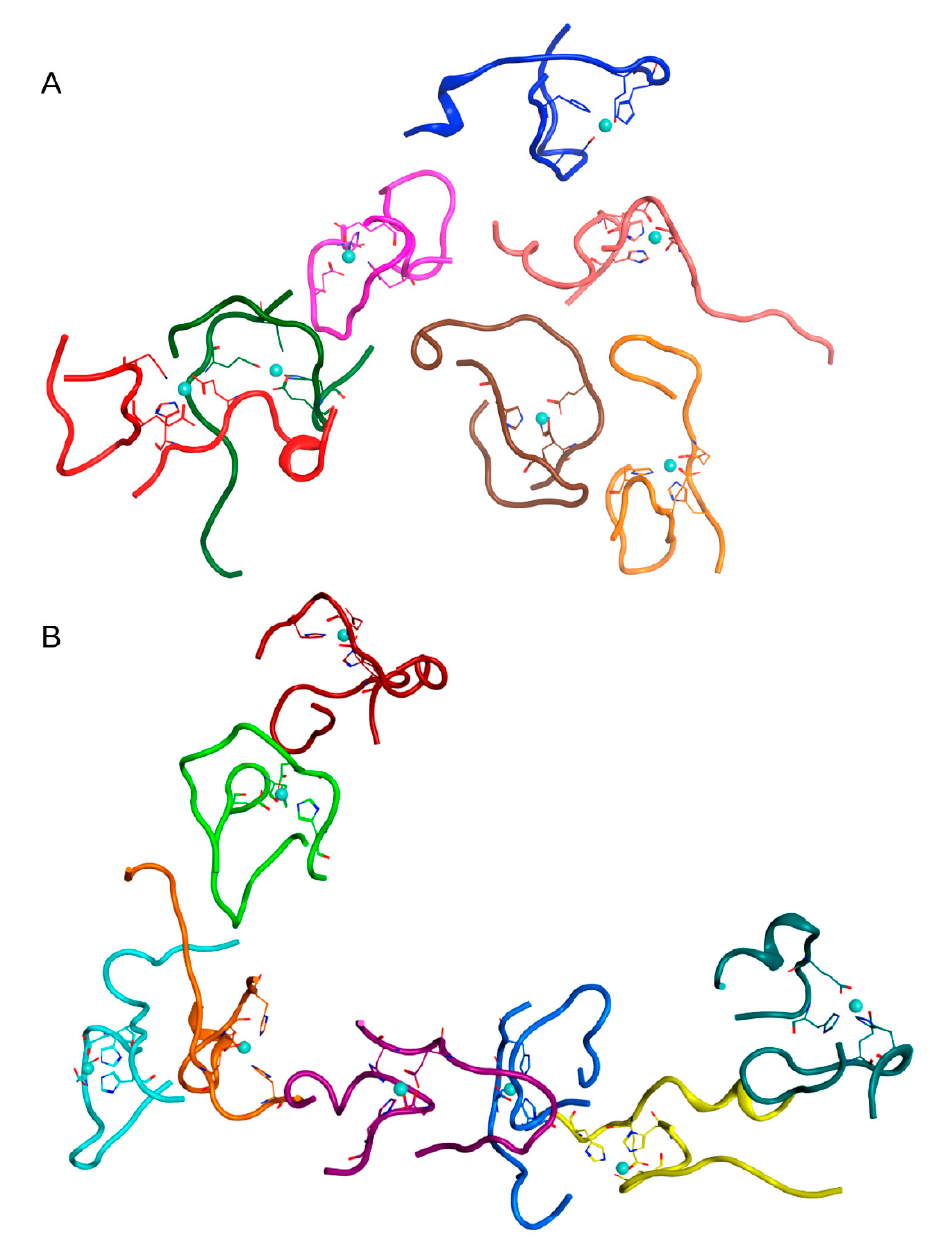
Zinc coordinating side chains are shown. Zinc ions are highlighted in blue. The Аβ 16 dimer (bottom right corner in A ) is colored red.